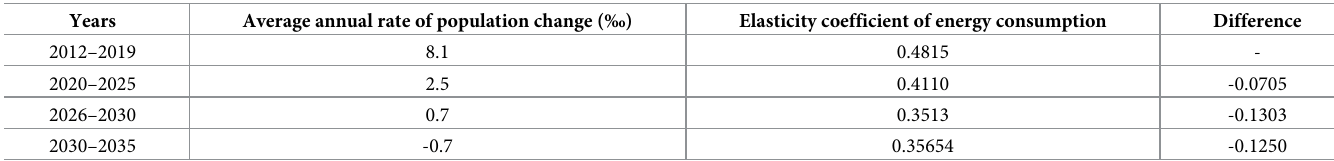
Table 6. Population growth rate